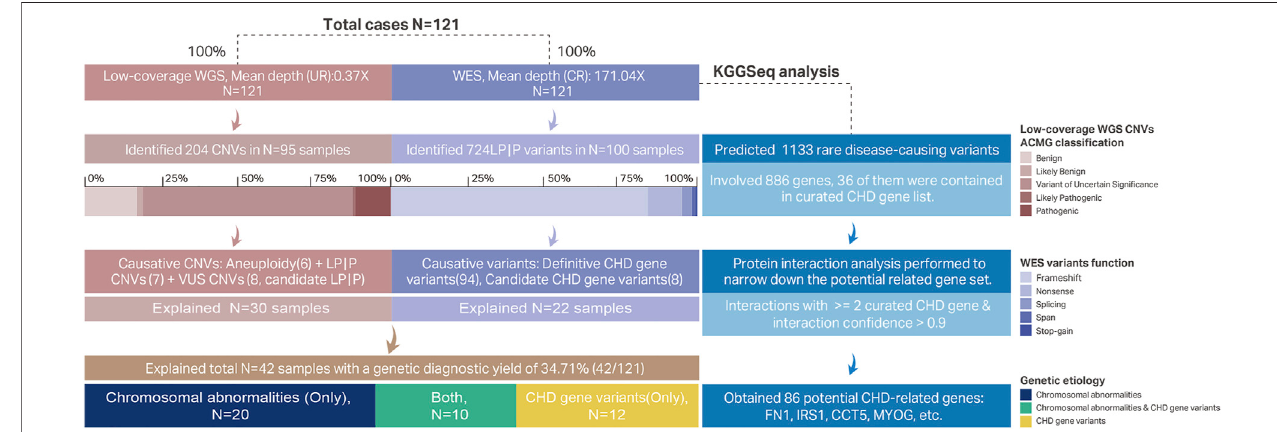
FIGURE1| Methodologicalwork fl owsofgeneticetiologicaldiagnosisandCHD-relatedgeneprediction. Eachcasehadconductedlow-coverageWGSandWES. The unique reads mean depth of whole-genome by low-coverage WGS was 0.37X. A total of 204 CNVs were identi fi ed in 95 samples, and the ACMG classi fi cations of these204CNVsweredemonstratedinastackedbarchart.Sixaneuploidyvariants,sevenLP|PCNVs,andeightcandidatesCHDpathogenicVUSCNVswereproposed as CHD causative CNVs. These 21 causative CNVs all explained 30 samples and some of the causative CNVs were diagnosed repeatedly in multiple samples ( Table 3 ). The mean depth in the capture region of WES was 171.04X. Total 724 P|LP variants were identi fi ed in 268 genes involving 100 samples and their functional effect was shown in a stacked bar chart. Among these 724 P|LP variants there were 94 variants belonging to 33 de fi nitive CHD genes and 8 variants belonging to candidate CHD-related genes. Combined with low-coverage WGS and WES, there were 42 samples identi fi ed with genetic etiology with a 34.71% diagnostic yield. We also explored the potential CHD association genes by KGGSeq software based on WES data. A total of 1,133 variants on 886 genes were predicted as rare disease- causing. 36 of the 886 were de fi nitive CHD-related genes. The left 850 genes were further narrowed down based on interactions with curated CHD genes. Finally, 86 genes were proposed as CHD-related genes. Abbreviations: UR, unique reads; LP|P, likely pathogenic or pathogenic; CR, capture region.